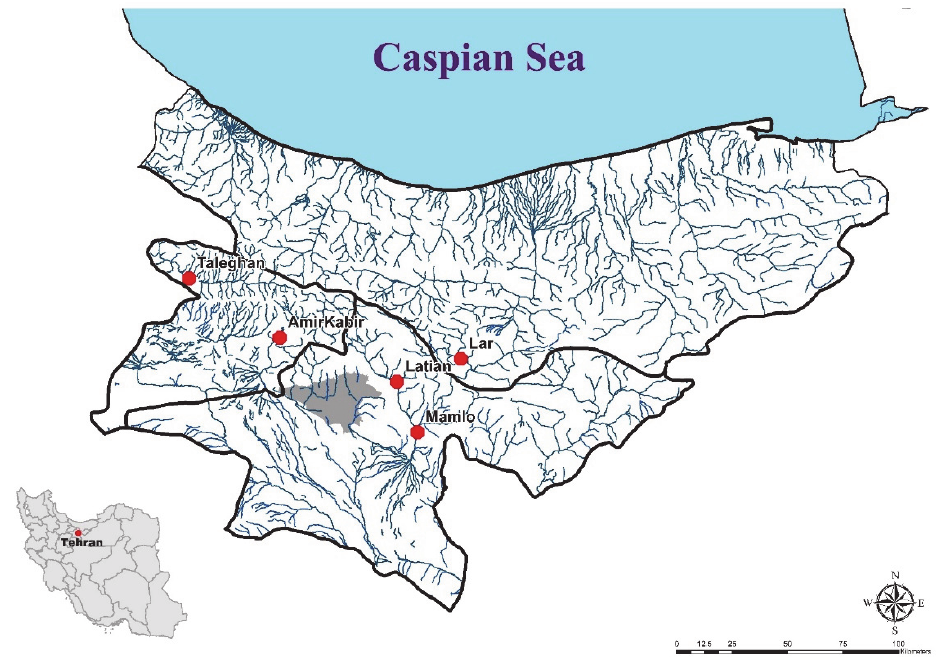
Figure 2. Locations of water supply dams in Tehran.